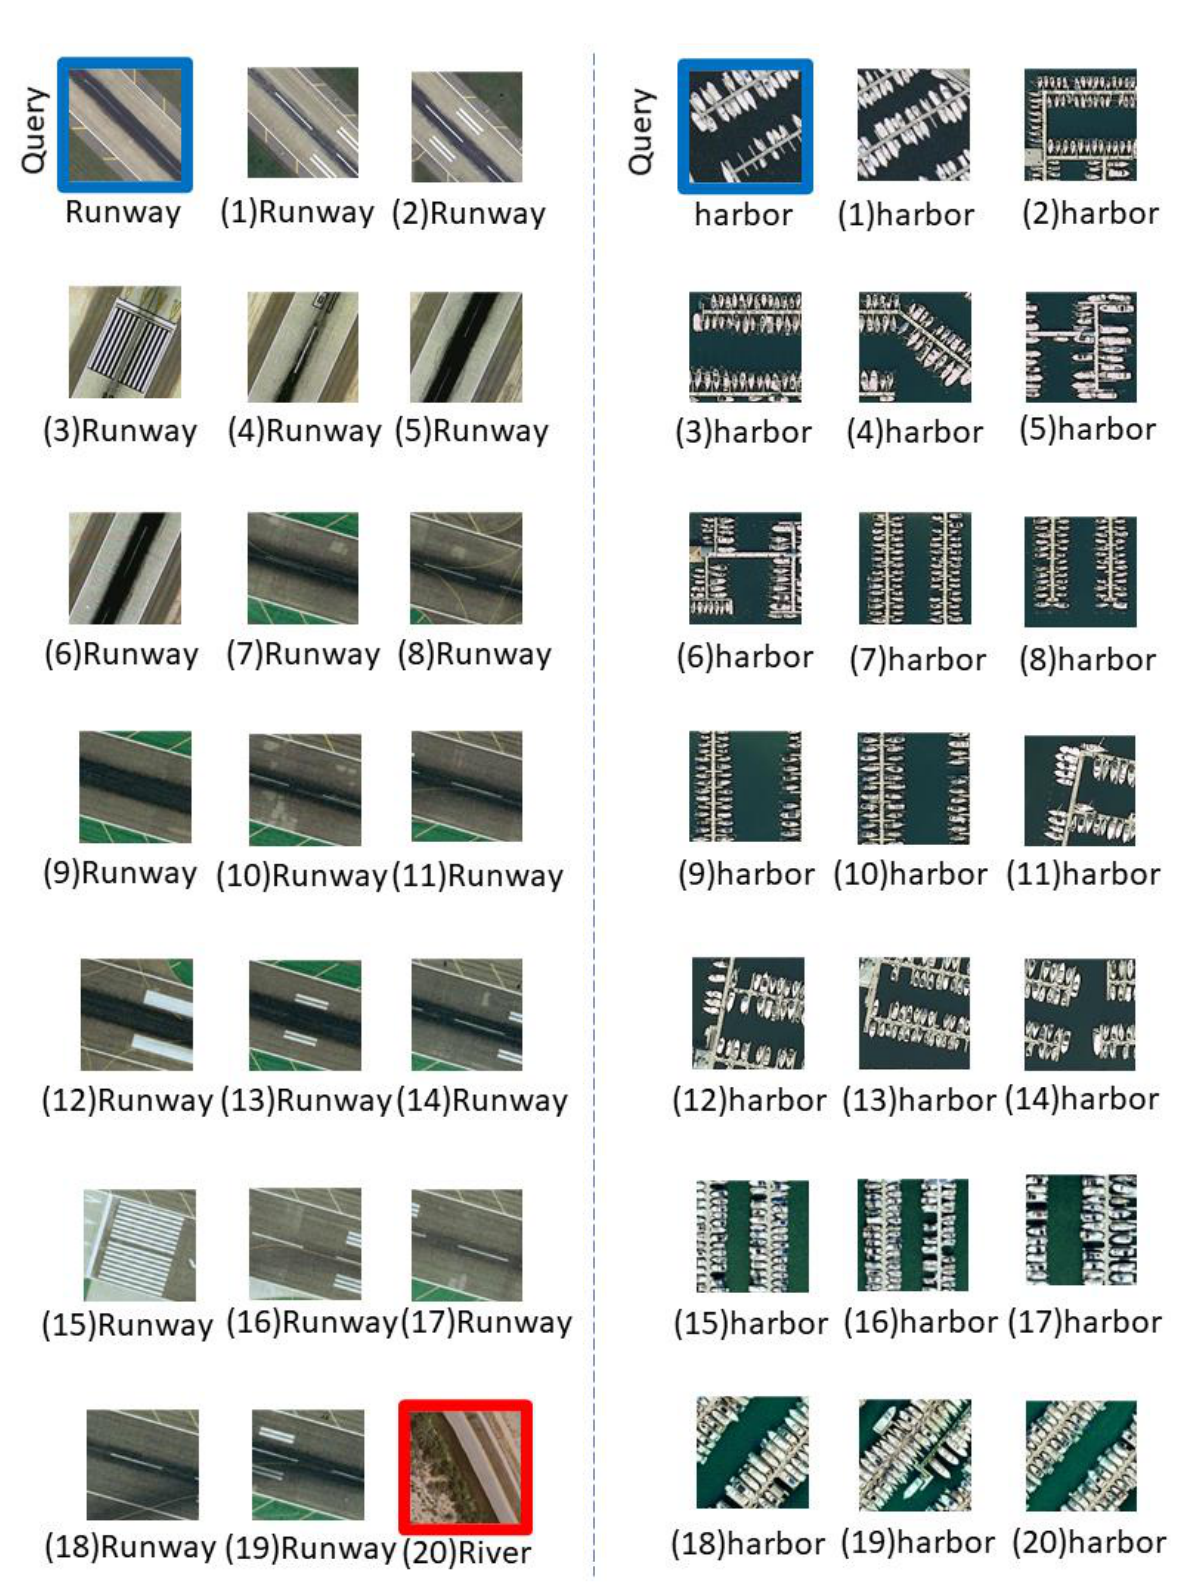
Figure 5. The top 20 retrieval results of our DHCL method on UCMD. The dotted line separates the retrieval results of different classes. The blue box is used to frame the query image, and the red box is used to frame the wrong retrieval result. The words indicate the ground truth of the images above it.